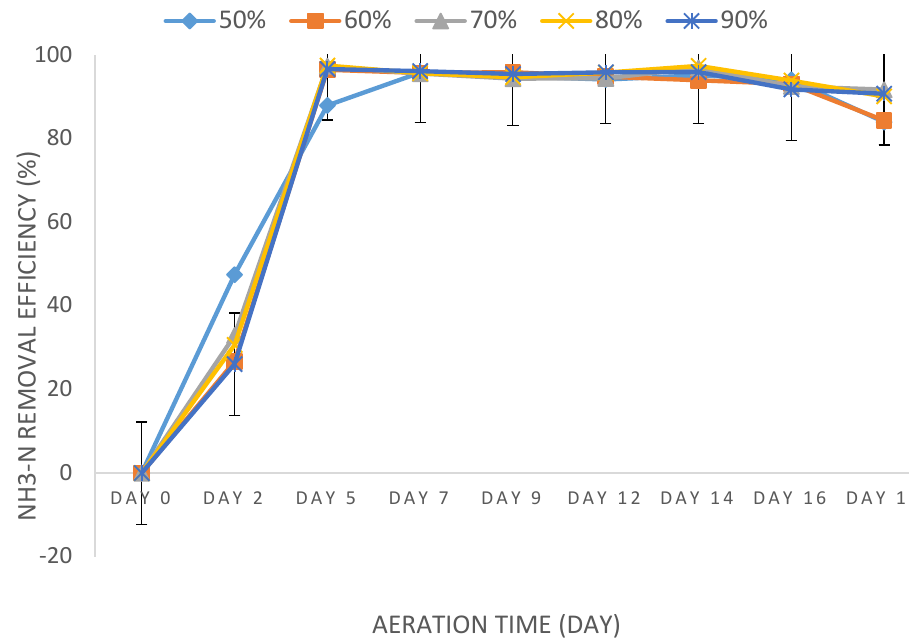
Figure 5. The effect of wastewater mixing ratio on NH 3 -N removal efficiency.